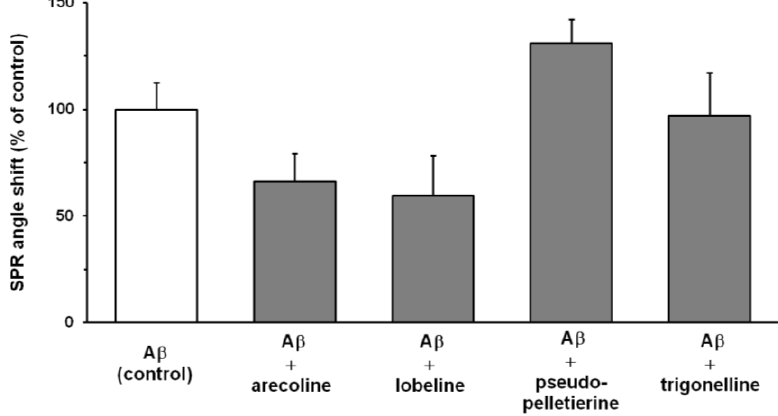
aggregation on an Aβ 40